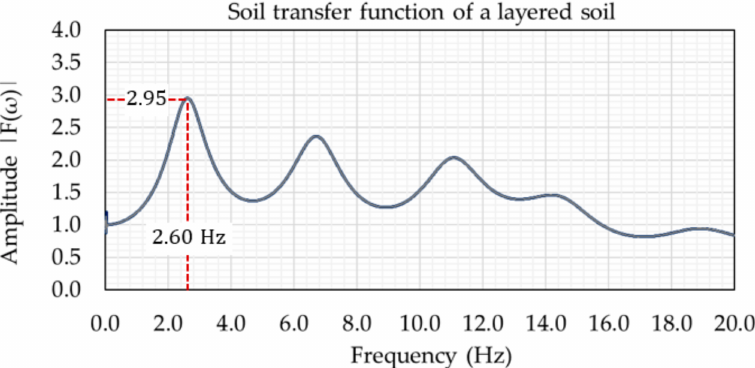
Figure 12. Transfer function graph | F ( ω ) | and amplitudes for a layered